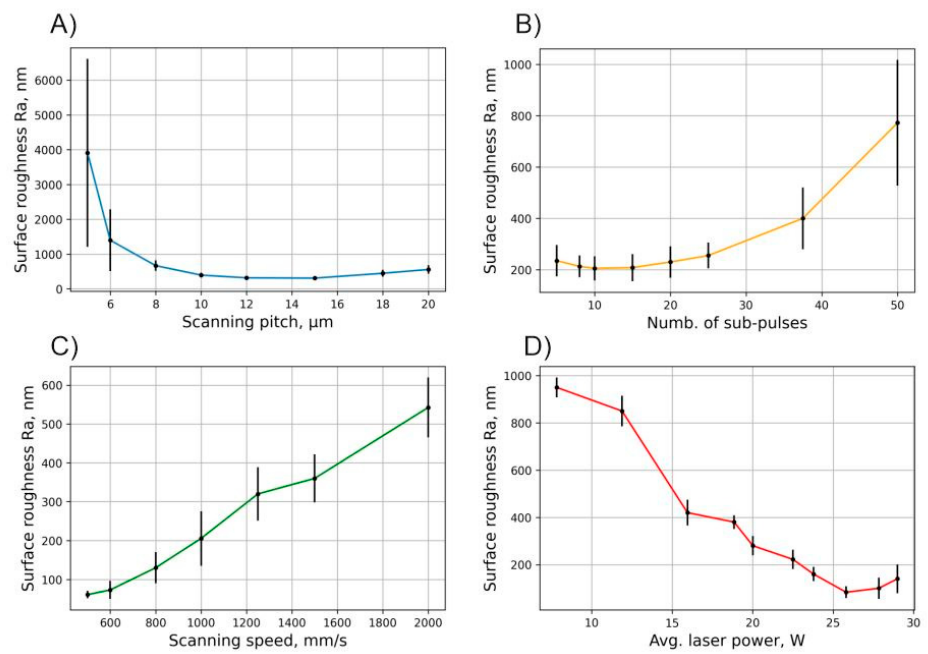
Figure 5. Surface roughness after polishing ablated samples dependent on di ff erent polishing parameters. Other fixed parameters in case of ( A ): P = 29 W, N p = 10 and v = 1000 mm / s; in case of ( B ): P = 19 W, dx = 10 µ m and v = 1000 mm / s; in case of ( C ): P = 25.8 W, dx = 10 µ m and N p = 10; and in case of ( D ): v = 1000 mm / s, dx = 10 µ m and N p = 5.